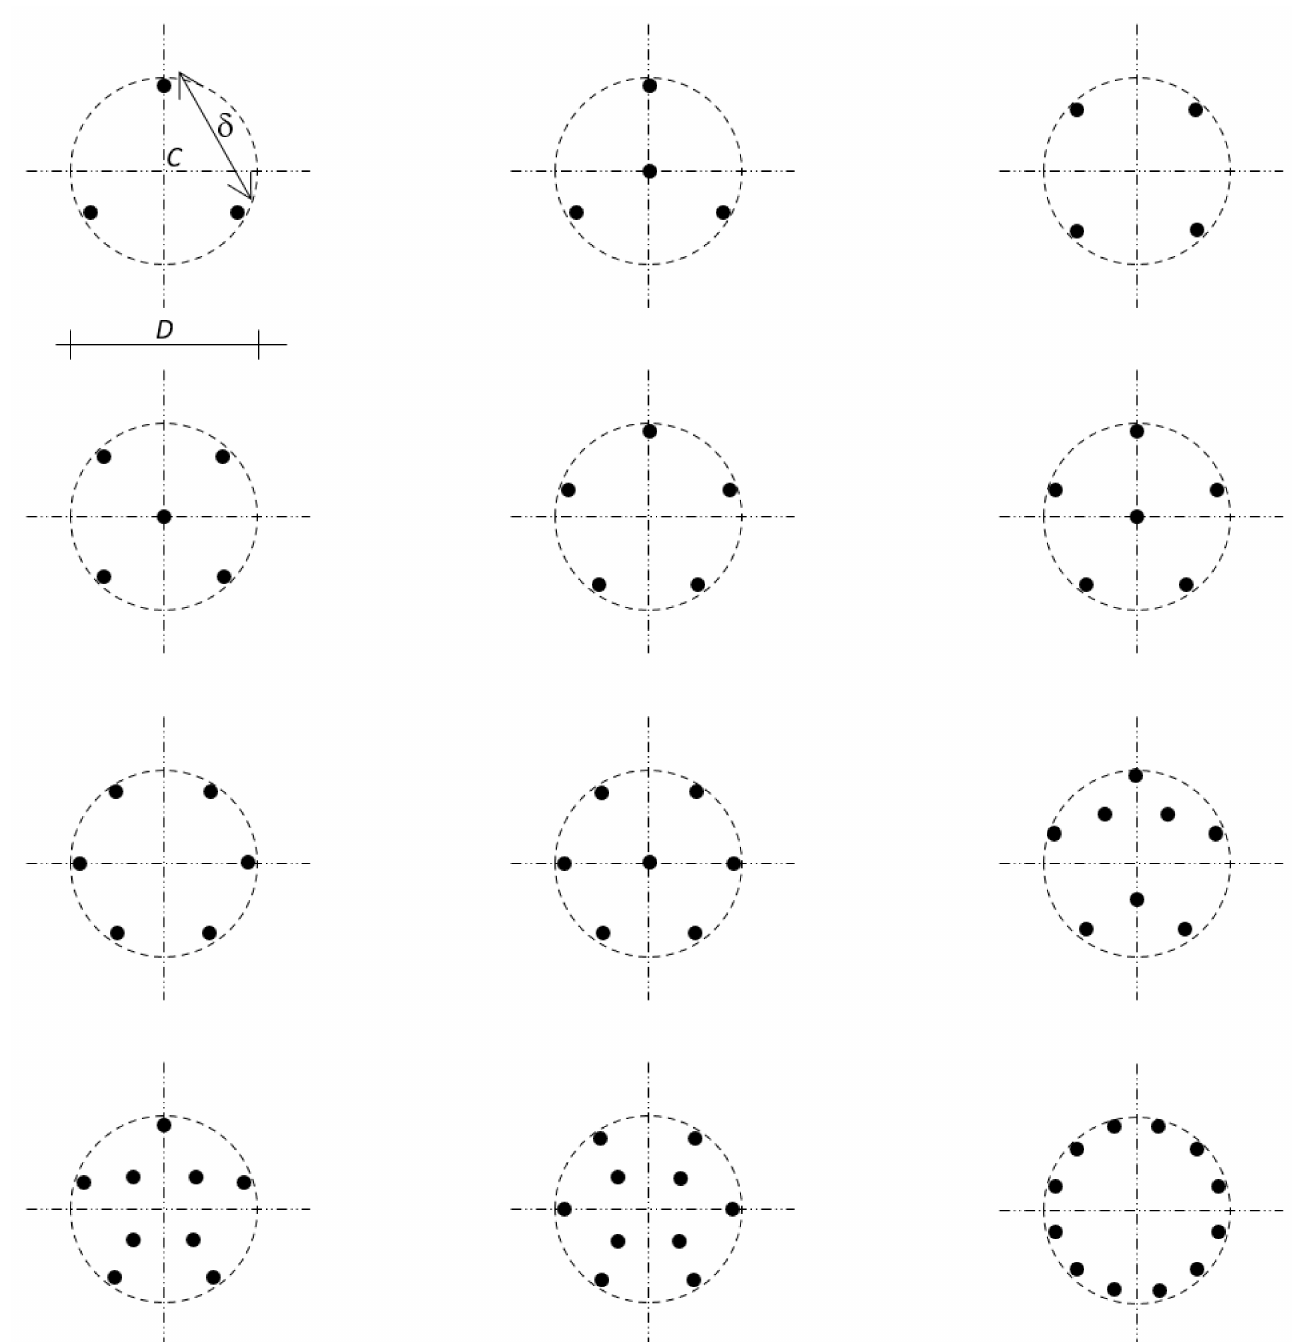
Figure 1. Possible patterns. Three-, four-, five-, six-, seven-, eight-, nine-, ten- twelve-anchor patterns. Each pattern is circumscribed by a circumference of diameter D and center C (these symbols are shown by the pattern 1-1 together with the spacing δ ). The circumscribing circumference defines a cylinder of diameter D and height L − e , called circumscribing cylinder. The shear force acting on an anchor group is applied at the center C of the circumscribing circumference (which lies on the concrete